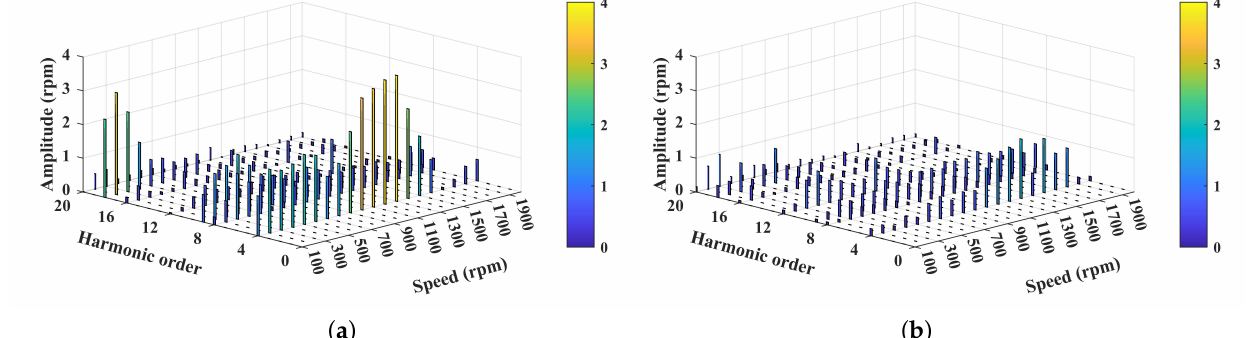
Figure 10. Spectrum analysis of the speed ripple: ( a ) in the conventional ESO-ADRC system and ( b ) in the modified NN-ESO-ADRC system with double